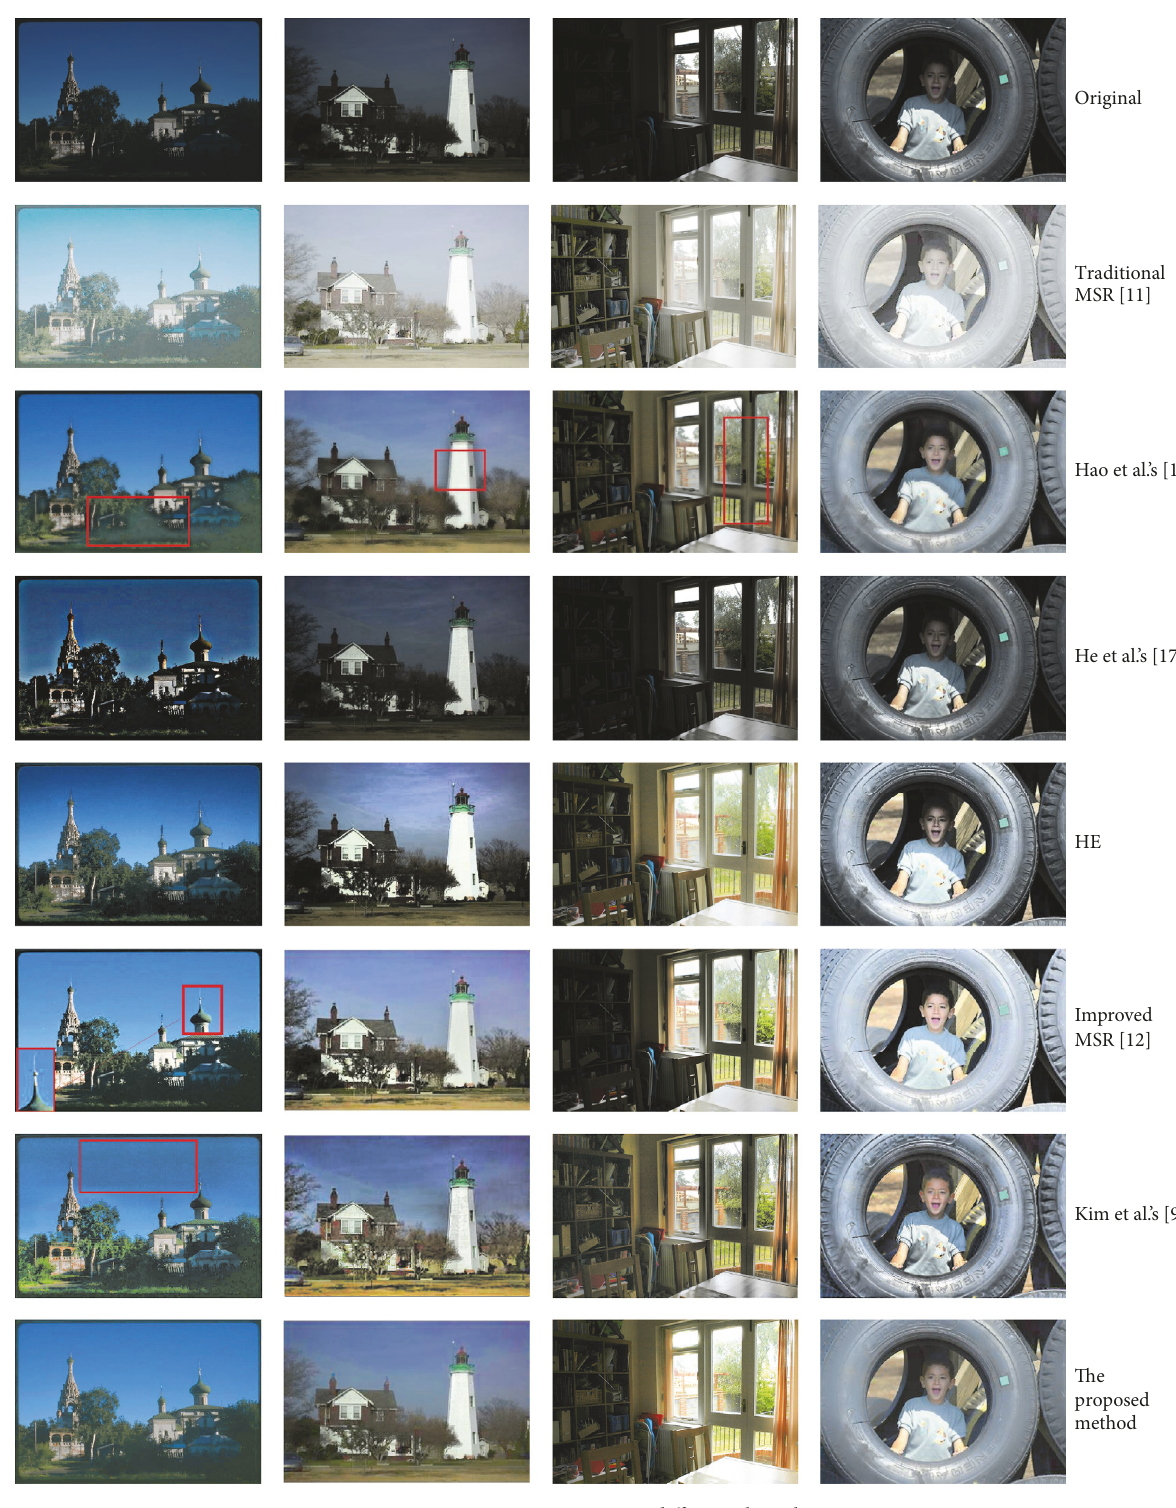
Figure 11: Comparison among different